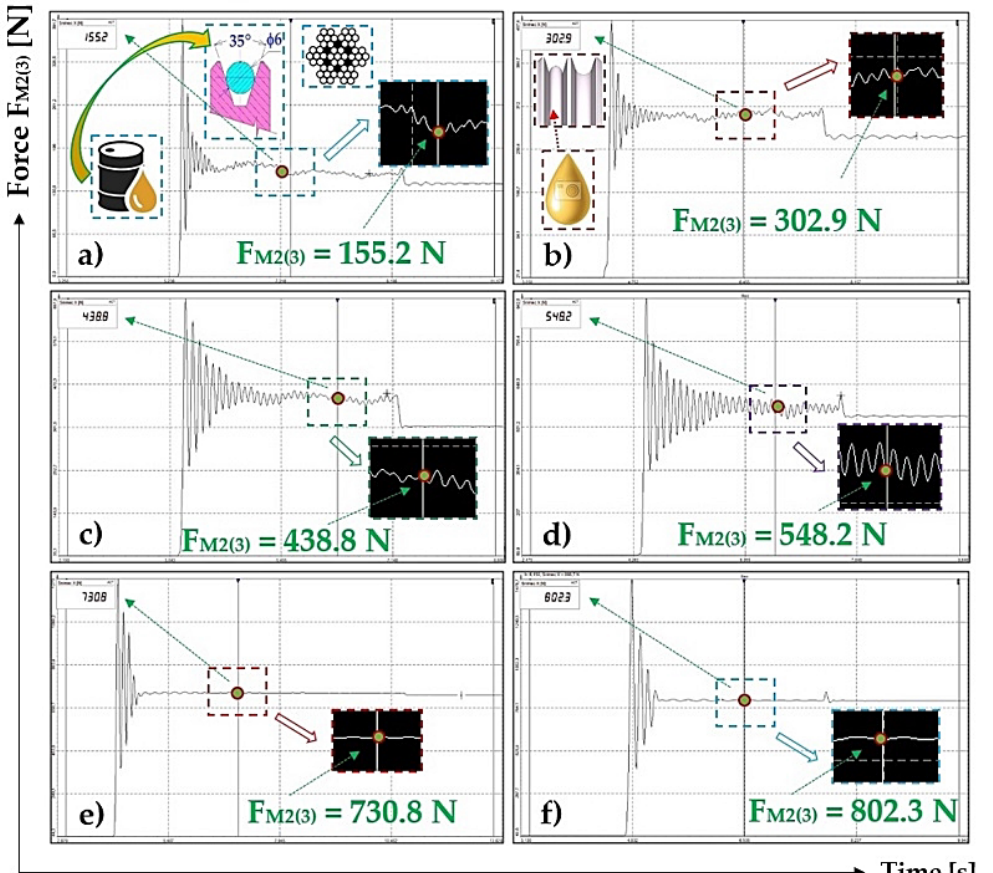
Figure 12. Measured tensile forces F M2(i) [N] done using DeweSoft ® measuring software for ϕ6 mm rope, V-shaped groove, with oil contamination (for weight of weights G z [N] ( a ) 49 N, ( b ) 98 N, ( c ) 147 N, ( d ) 196 N, ( e ) 245 N, ( f ) 294 N).